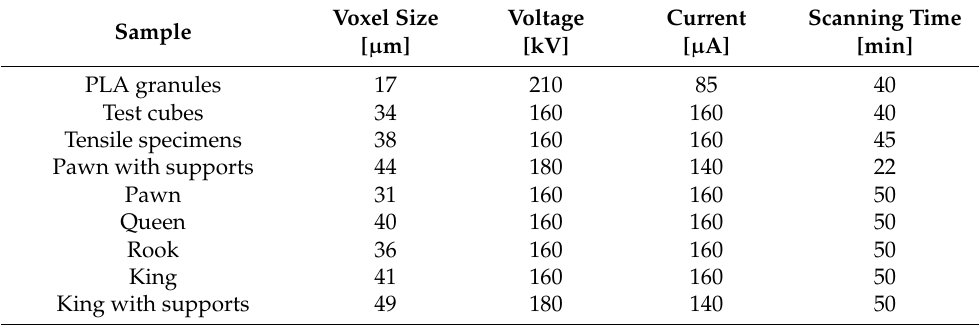
Table 3. X-ray scan